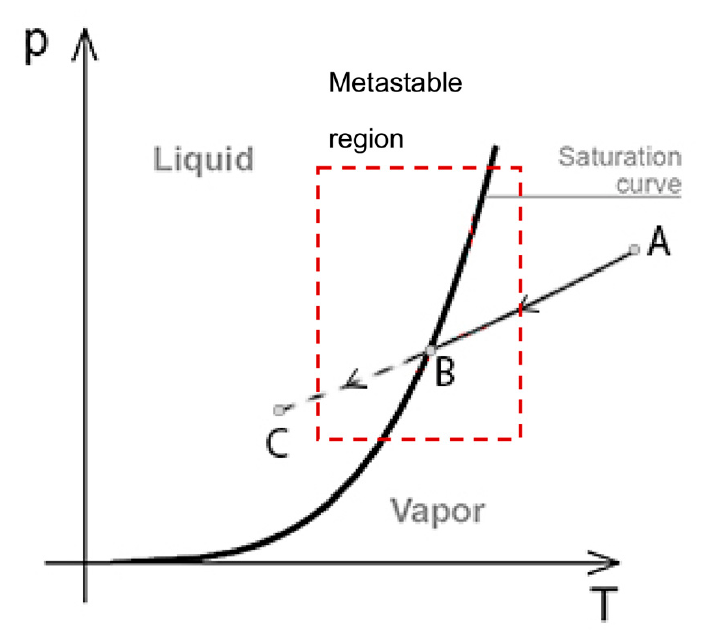
Figure 9. Pressure–temperature diagram showing the process of condensation due to pressure drop.